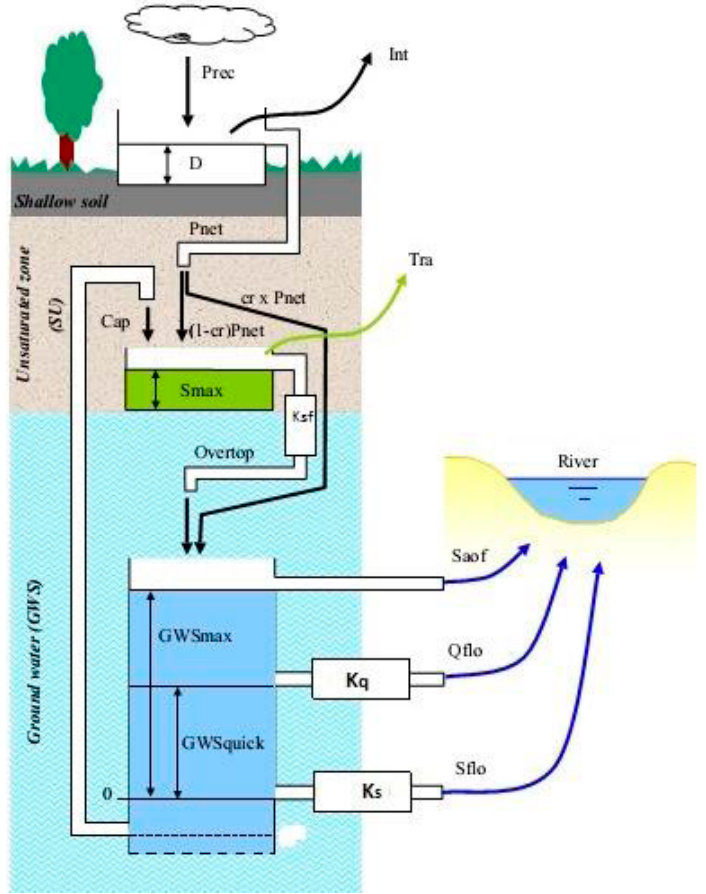
Figure 3. Model configuration [34,36].